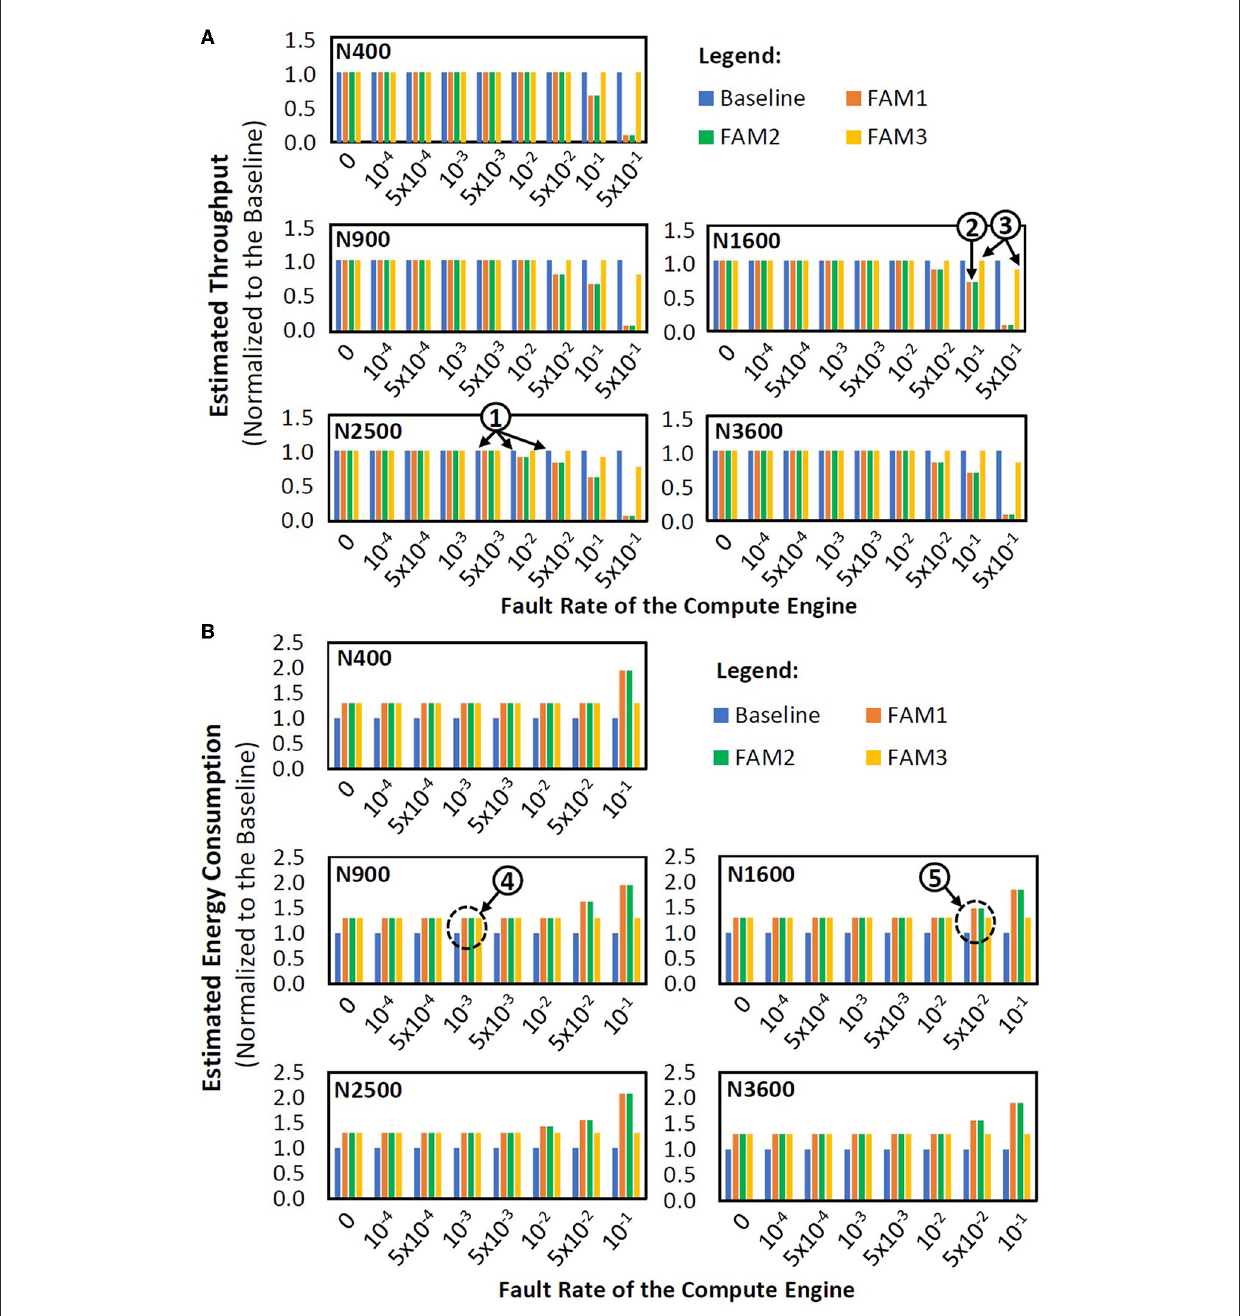
FIGURE15 (A) Throughput across different mitigation techniques, different model sizes, and different fault rates for both MNIST and Fashion MNIST, as they have a similar number of SNN weights and operations. (B) Energy consumption across different mitigation techniques, different model sizes, and different fault rates for both MNIST and Fashion MNIST, as they have a similar number of SNN weights and